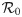
Sensitivity index of R0 with respect to V for different values of χ.